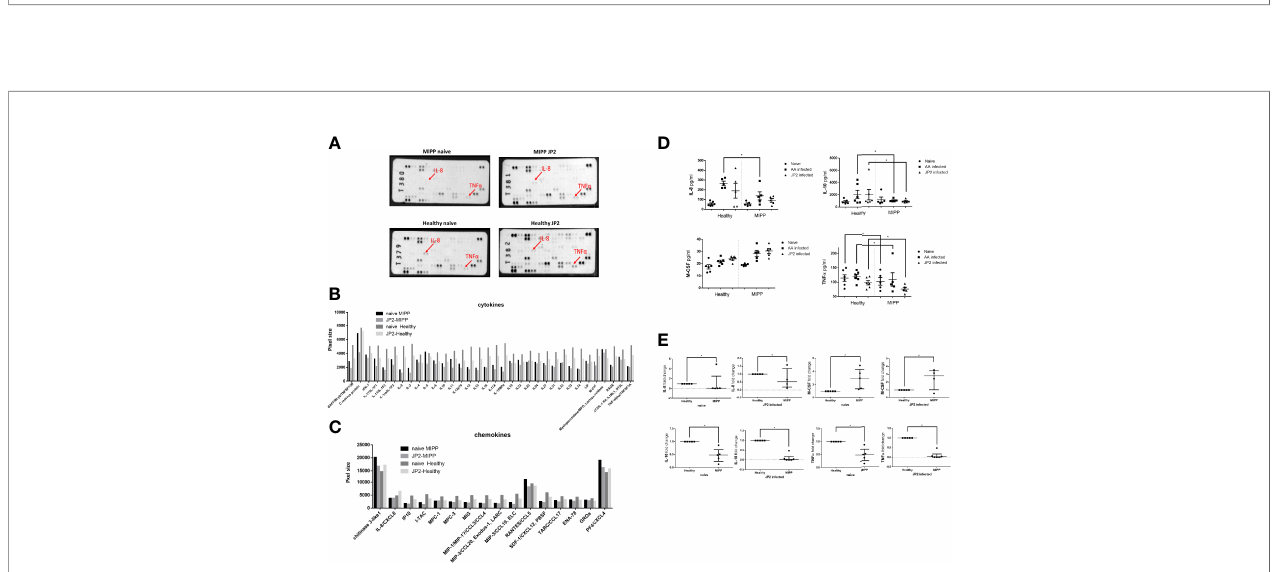
FIGURE 3 | Secretome pro fi ler quanti fi cation. The supernatants of neutrophils isolated from ten periodontally healthy cases and ten molar incisor pattern periodontitis (MIPP cases) that were incubated for 3hrs with A. actinomycetencoomitans (AA) or with the A. actinomycetemcomitans JP2 clone or were pooled. (equal volumes for each group) for the cytokine and chemokine secretion array. (A) Image of array membranes following analysis. The red arrows point to signi fi cant dots that show a change between groups. (B) Dot size quanti fi cation (in arbitrary values) of cytokines in the array for all four groups: MIPP with and without JP2 in comparison with healthy neutrophils with and without JP2. (C) Dot size quanti fi cation (in arbitrary values) of chemokines in the array for all four groups: MIPP with and without JP2 in comparison with healthy neutrophils with and without JP2. (D) ELISA quanti fi cation of IL-8, IL-10, M-CSF, TNF alpha for all case group supernatants (nonpooled samples). (E) Fold-change of real-time PCR quanti fi cation of IL-8, IL-10, M-CSF, TNF alpha for all case group supernatants (nonpooled samples). (*p <